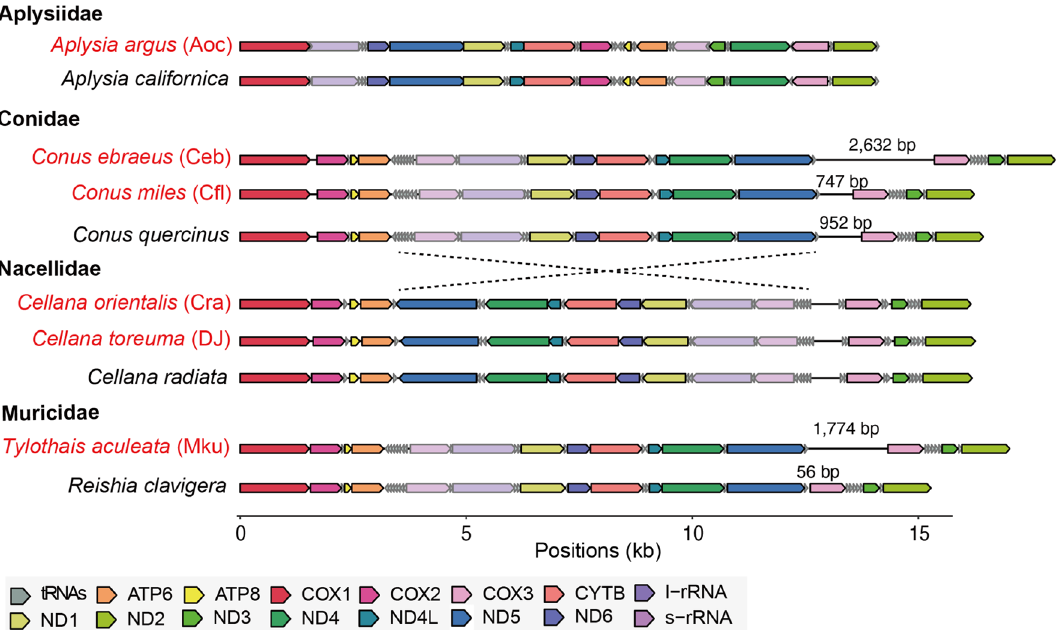
Figure 4. Synteny comparison among our samples and reference mitogenomes. Red labels denote our samples. The lengths of the control region between tRNA Phe and cox3 are shown when more than 1kb difference are observed between closely related